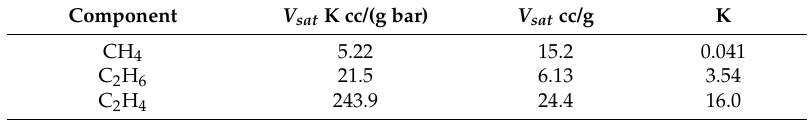
Table 1. Adsorption parameters of the Langmuir isotherm at 25 °C of the gas mixture.